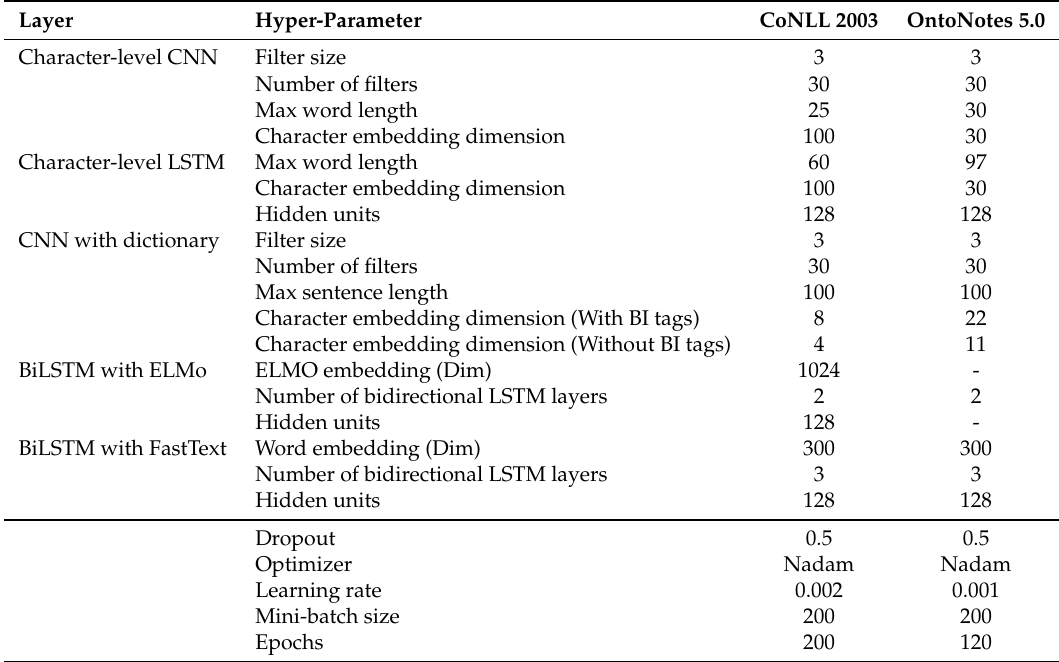
Table 3. The hyper-parameter values used in our